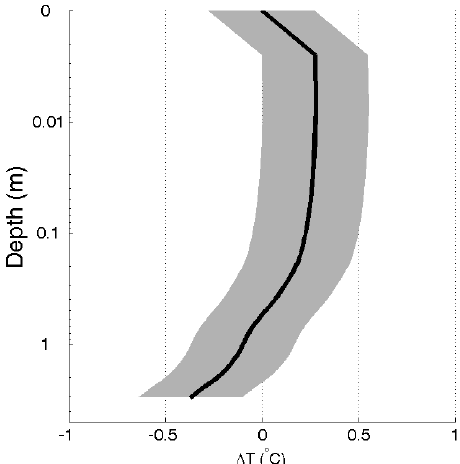
Fig. 9. Mean observed temperature profile for all available data Fig. 9 : Mean observed temperature profile for all available data (1,165 profiles collectively (1165 profiles collectively from GC99, GL03 and IO07 data sets) from GC99, GL03 and IO07 datasets) referenced to the mean SST Skin value. The shaded region referenced to the mean SST Skin value. The shaded region represents represents the 95% confidence interval. the 95% confidence interval.